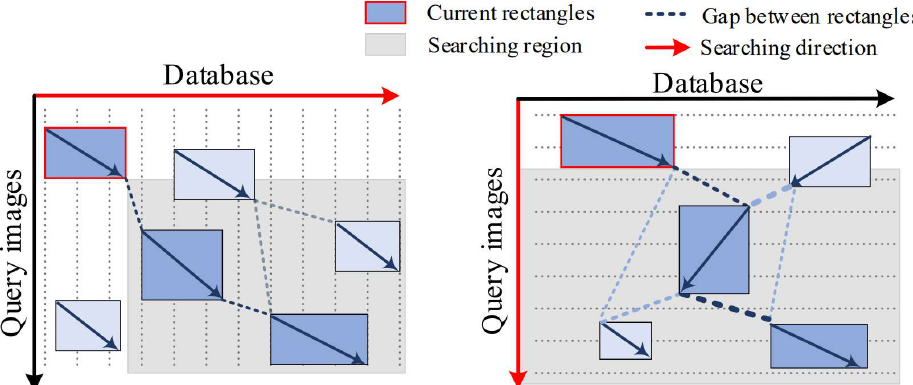
Figure 3. Comparison of existing and proposed rectangle chaining algorithms. The existing sparse DP algorithm ( left ) and the proposed algorithm ( right ). The proposed algorithm not only detects the robot’s forward motion but also detects backwardness using a rectangle chaining